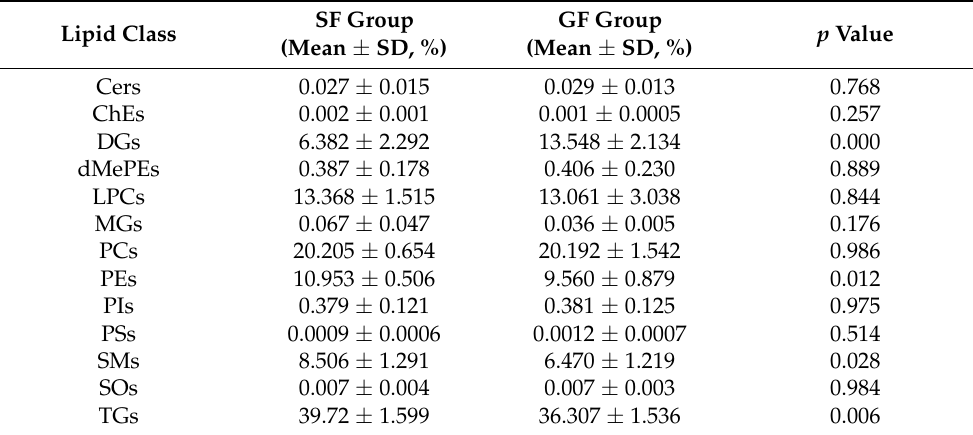
Table 1. The composition of lipid classes in the subcutaneous fat of yaks under stall (SF) and graze feeding (GF). Lipid Class